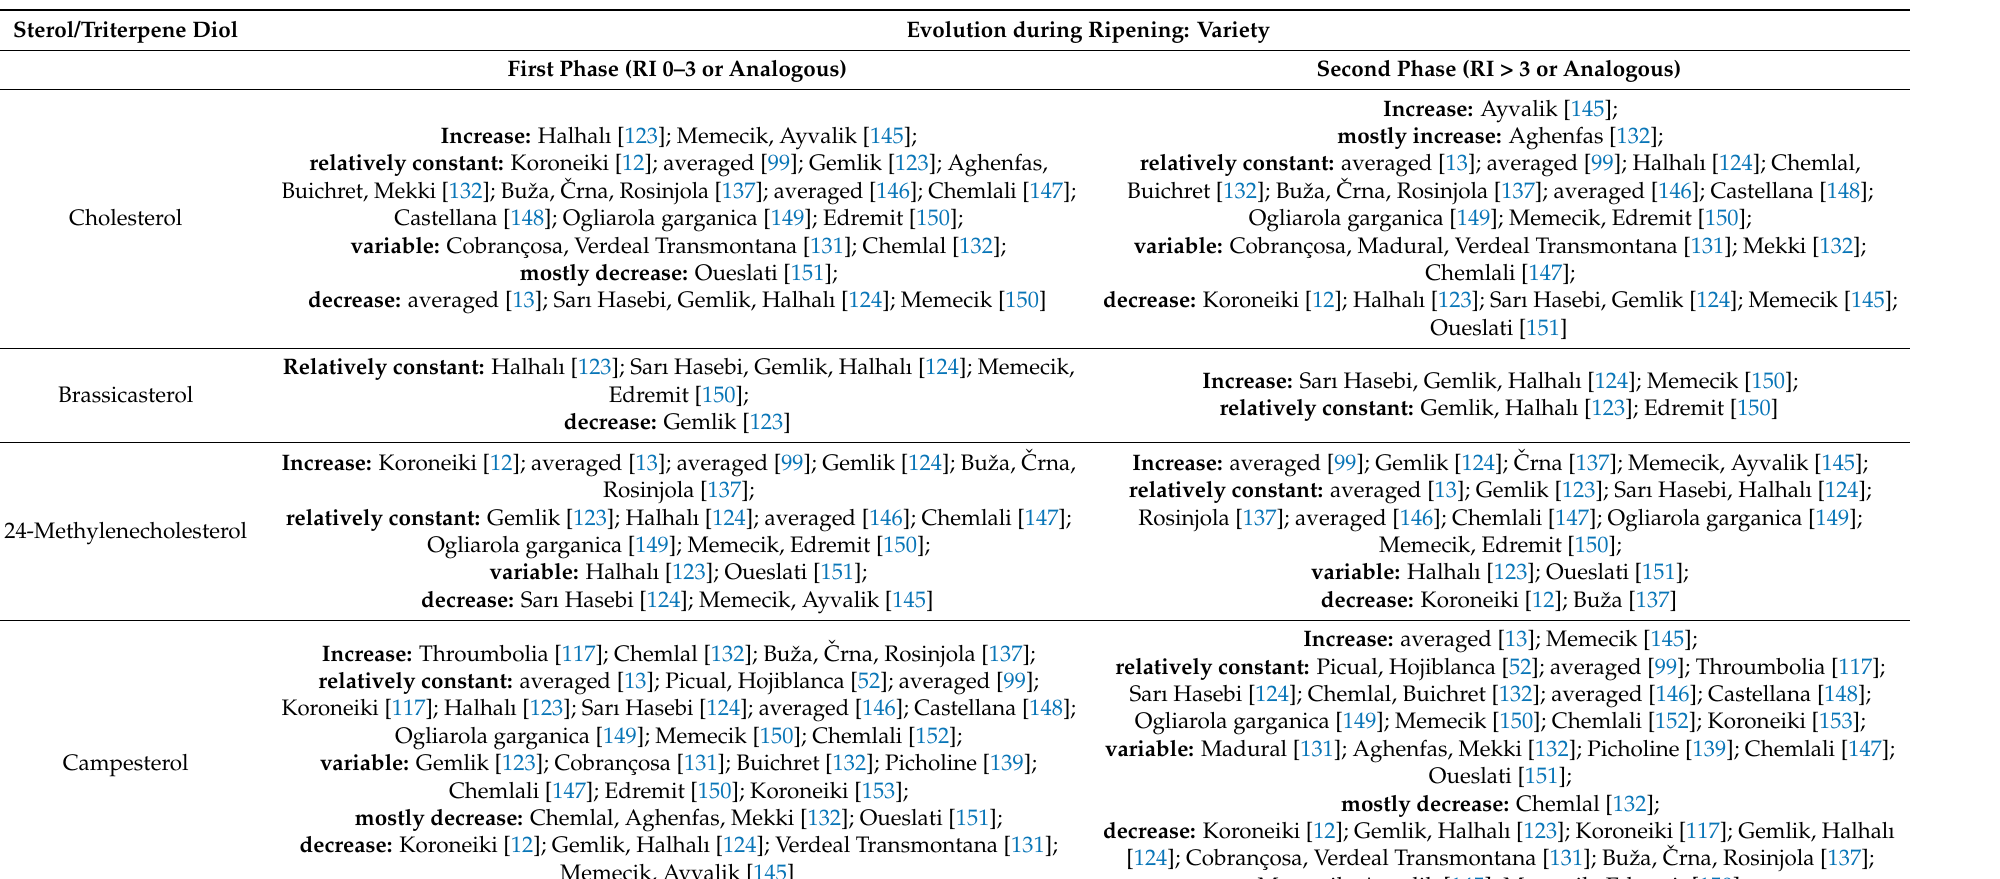
Table 3. Evolution of sterols and triterpene diols during ripening of olives from different varieties based on their levels in olive oils produced therefrom. Sterol/Triterpene Diol Evolution during Ripening: Variety First Phase (RI 0–3 or